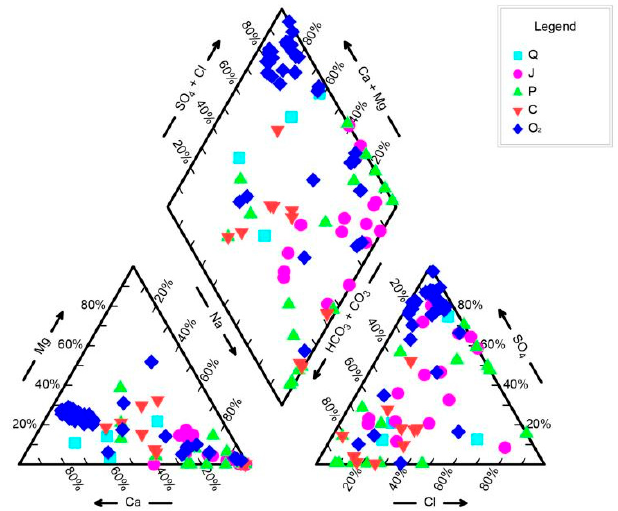
Figure 2. Piper Figure 2. Piper Diagram.